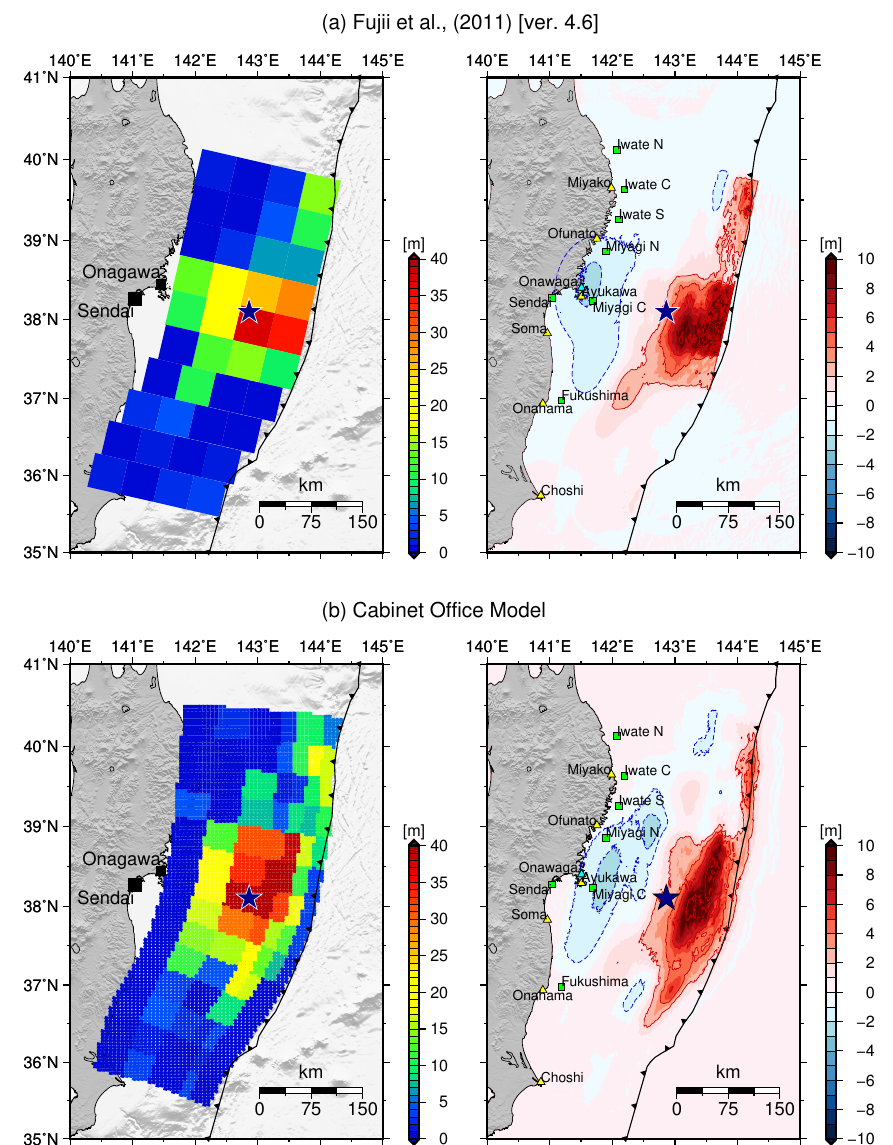
Figure 1. ( a ) Fault slip distribution and corresponding coseismic displacement was calculated using model A (Fujii et al. [1]). The blue star indicates the location of the epicentre as per the Japan Meteorological Agency (JMA). The black rectangles show the target areas used for the tsunami inundation modelling. ( b ) Total slip distribution and corresponding coseismic displacement was calculated using earthquake source model B ([9]). The triangles and squares indicate the location of the coastal tide gauge and offshore GPS wave gauge stations, respectively. Colours indicate the operating agencies (Green: the Nationwide Ocean Wave Information Network for Ports and HArbourS (NOWPHAS) of Japan; yellow: Japan Meteorological Agency (JMA); and light blue: the Onagawa Nuclear Power Plant of the Tohoku Electric Power Company of Japan). The contour lines in the left panels are drawn at 1-m